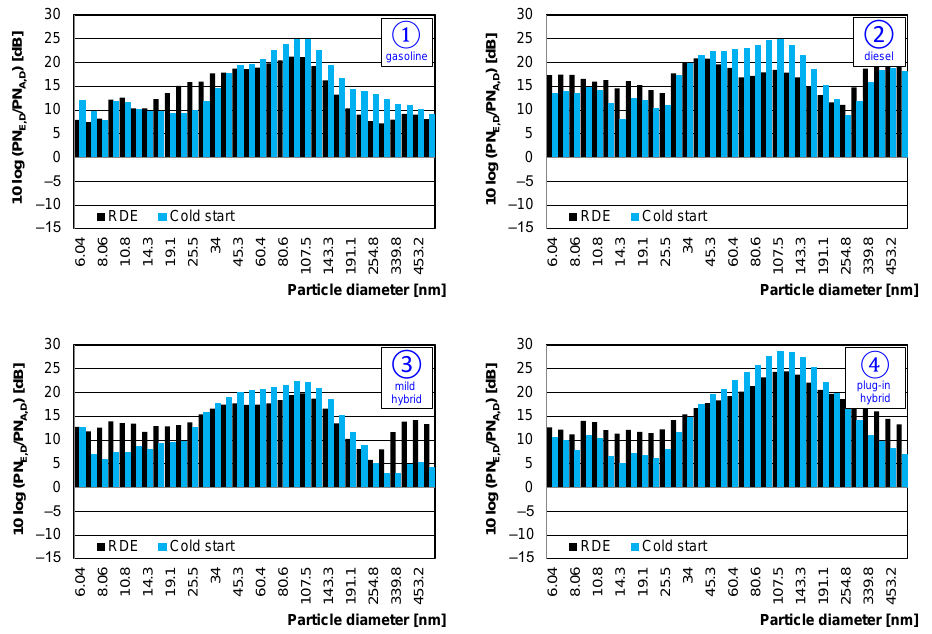
Figure 11. Particle number increase rate for vehicles 1 – 4 in the cold start phase of the engine and throughout the RDE test; 1 — gasoline, 2 — diesel, 3 — mild hybrid, 4 — plug-in hybrid.